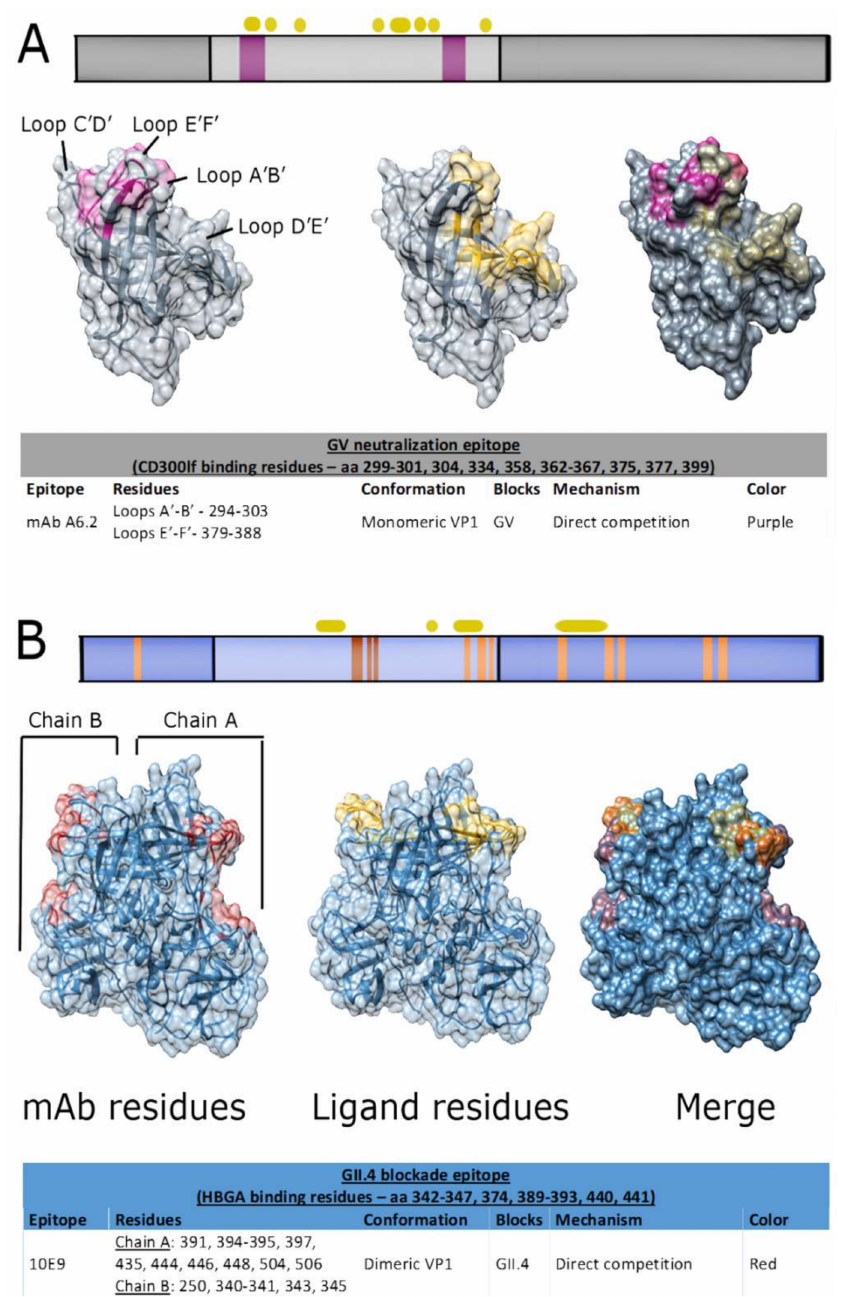
Figure 5. Relationship of two neutralizing B cell epitopes to receptor or HBGA binding sites. ( A ) MNV neutralizing epitope mapping to the P2 domain. Neutralizing mAb A6.2 binds to a conformational epitope (purple) that overlaps the CD300lf receptor binding domain (gold). ( B ) GII.4 neutralizing epitope mapping to the P2 domain. Neutralizing mAb 10E9 binds to an epitope that spans the P2 strains [65]. 2D3 is predicted to recognize some of the same residues as MAb A6.2 and possibly overlap with the CD300lf binding site [172]. Interestingly, resistance mutations to 2D3 took about 20 passages to become detectable, which suggested that the 2D3 mAb recognized critical residues involved in receptor binding [65]. Amino acid changes that resulted in loss of neutralization for both MAb A6.2 and 2D3 forced the P domain into an unfavorable conformation, instead of altering the dimer interface (orange). HBGA binding residues are highlighted in gold. Adjacent tables record epitope specificities and coloring that corresponds to the positions of the amino acids on both the linear and three-dimensional diagrams. ChimeraX was used to model amino acid binding sites (MNV PDB 6C6Q, GII.4 PDB